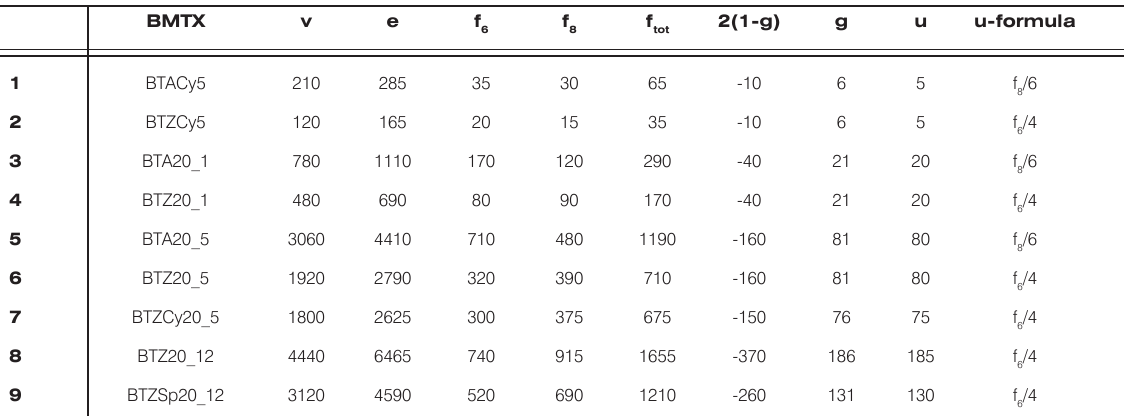
Figure 6. BTZCy5: five tetrapodal units (each closing its own ring) joined at the central ring, thus the genus is calculated g=5+1. Table 1. Euler formula calculation in multi tori BTX.